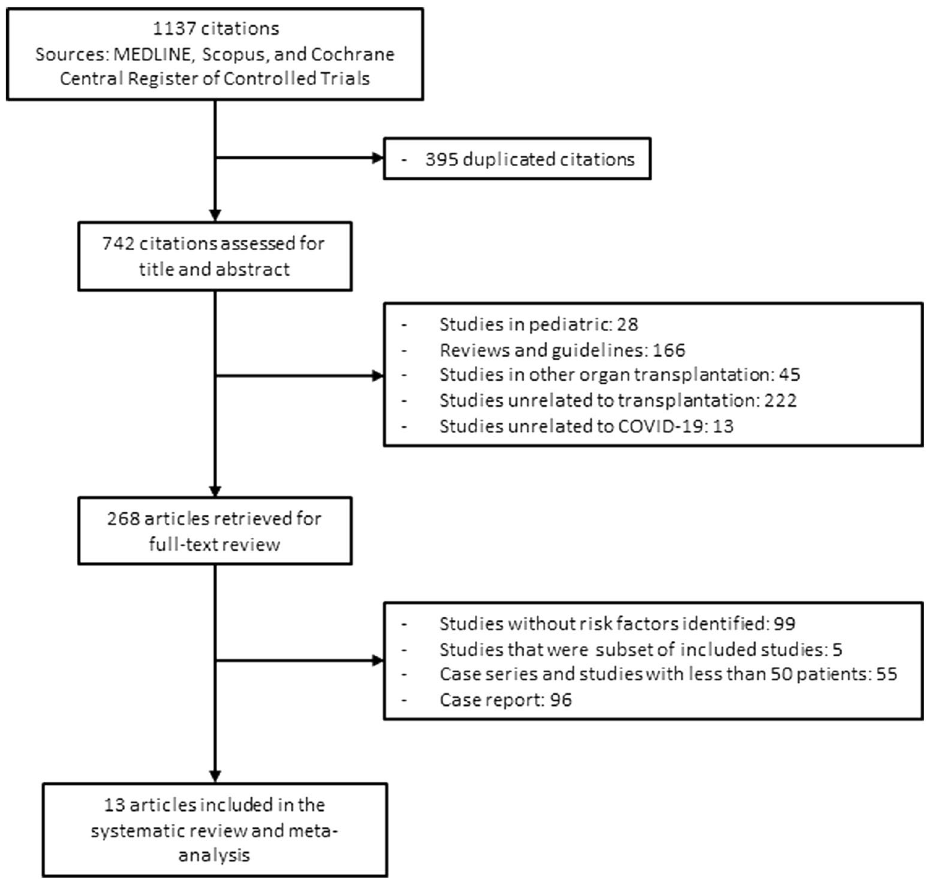
Figure 1. Flow diagram of study